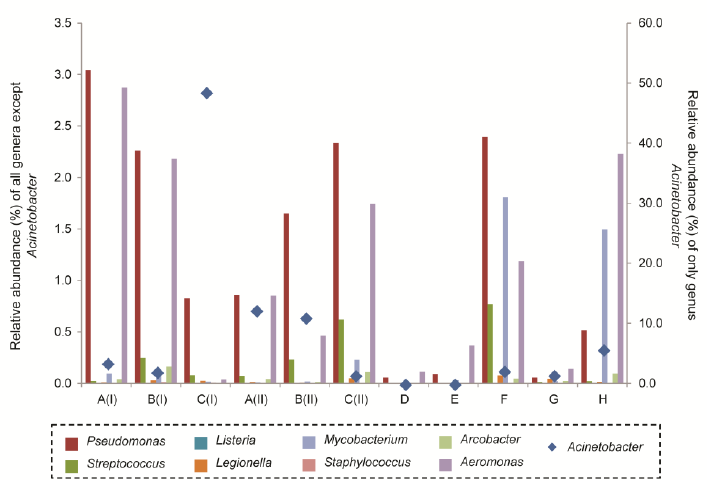
Figure 3. Relative abundance of genera associated with opportunistic pathogens in the groundwater collected from respective wells A through H. The relative abundance was compared to the total groundwater microbial community analyzed using high-throughput